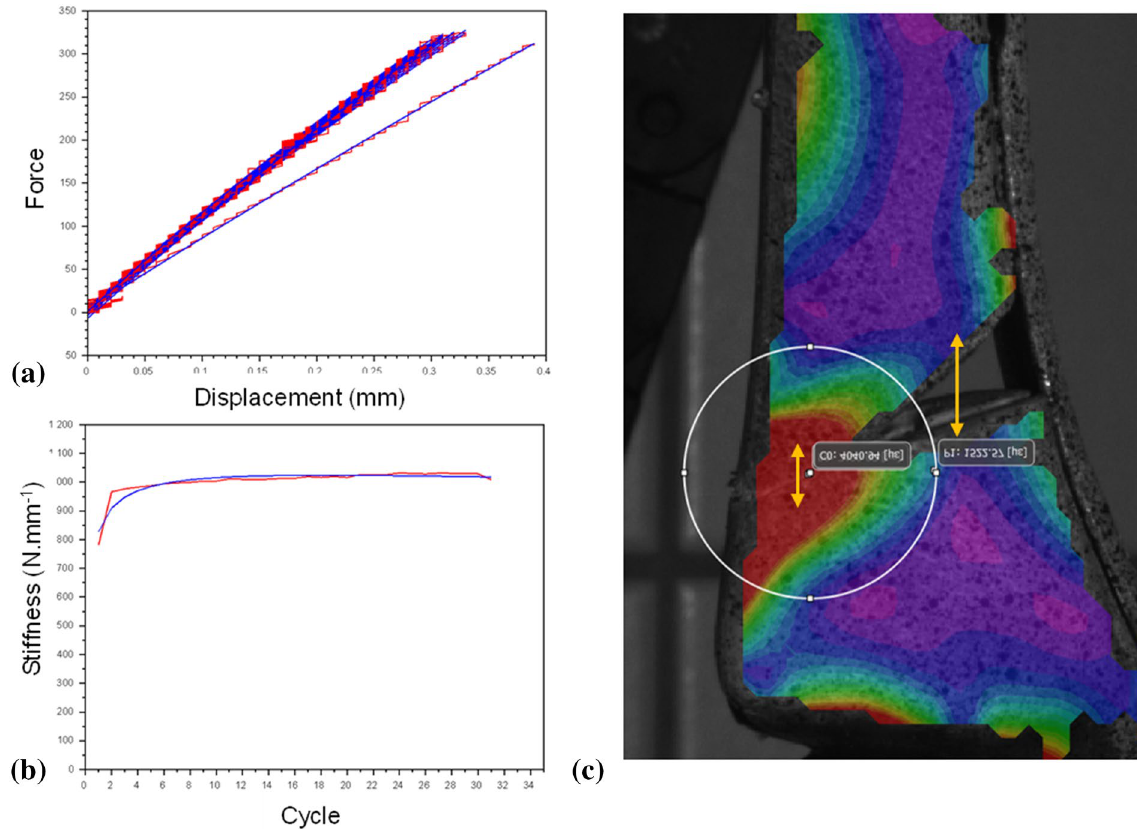
Figure 2. Force–displacement ( a ) and stiffness ( b ) curves for a given sample. The red line indicates raw data while the blue line indicates interpolated data using a 2nd order polynomial trend-line. Extensometer (yellow arrows) and nodal disc outline (white circle) placements for measurement of osteotomy gap displacement and strain due to extra-axial compression ( c ); red/warm colours indicate high Von Mises’ strain, blue/cold colours indicate low Von Mises’ strain. The example strain image was obtained from Vic3D software (version 8), https:// www. corre lated solut ions. com/ vic-